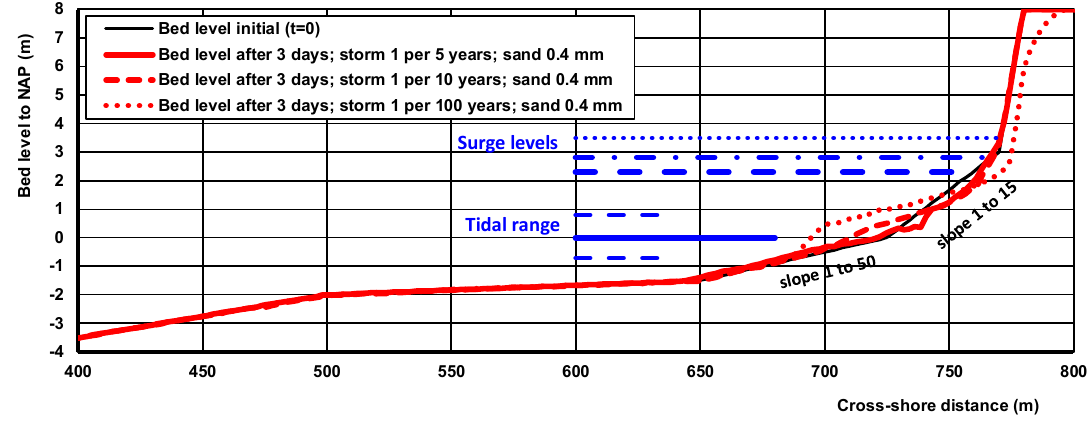
Figure 8. Computed beach erosion for decadal storms; Crosmor-model. Table 3. Erosion due to storms on decadal time scale; d 50 = 0.4 mm.